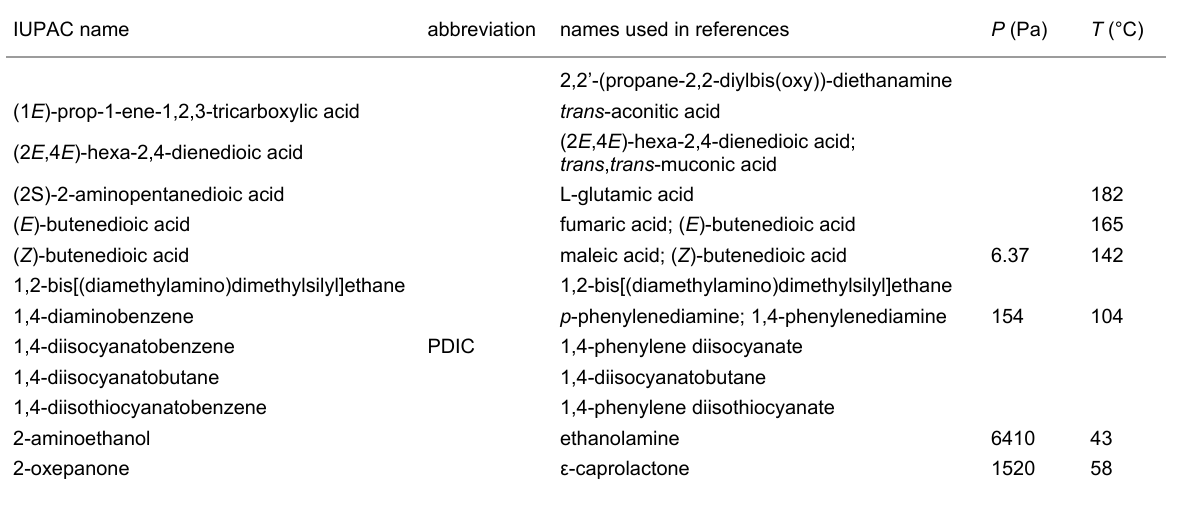
Table 1: Organic compounds (and their different names and abbreviations) employed in MLD and ALD/MLD processes together with vapor pres- sures, P , at 100 °C and temperatures, T , corresponding to a vapor pressure of 2 mbar for some of the organic precursors (the values were calculated by using the equations and parameters obtained from the DIPPR Project 801 database (full version)